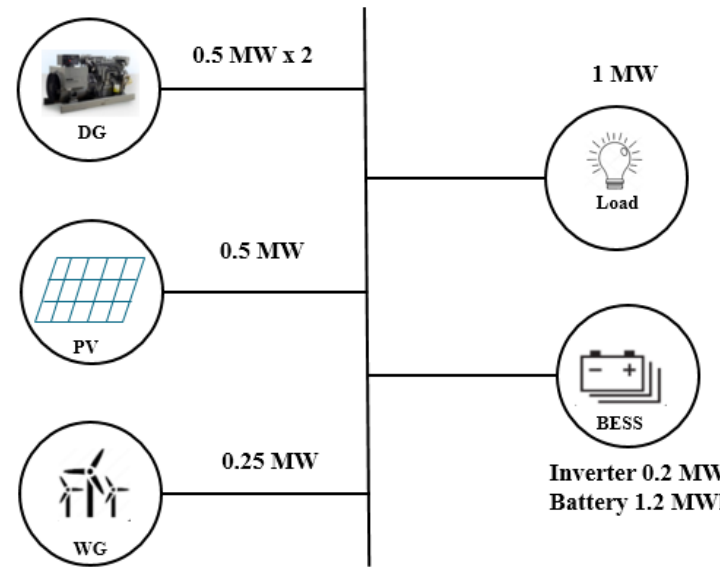
Figure 1. Proposed power system